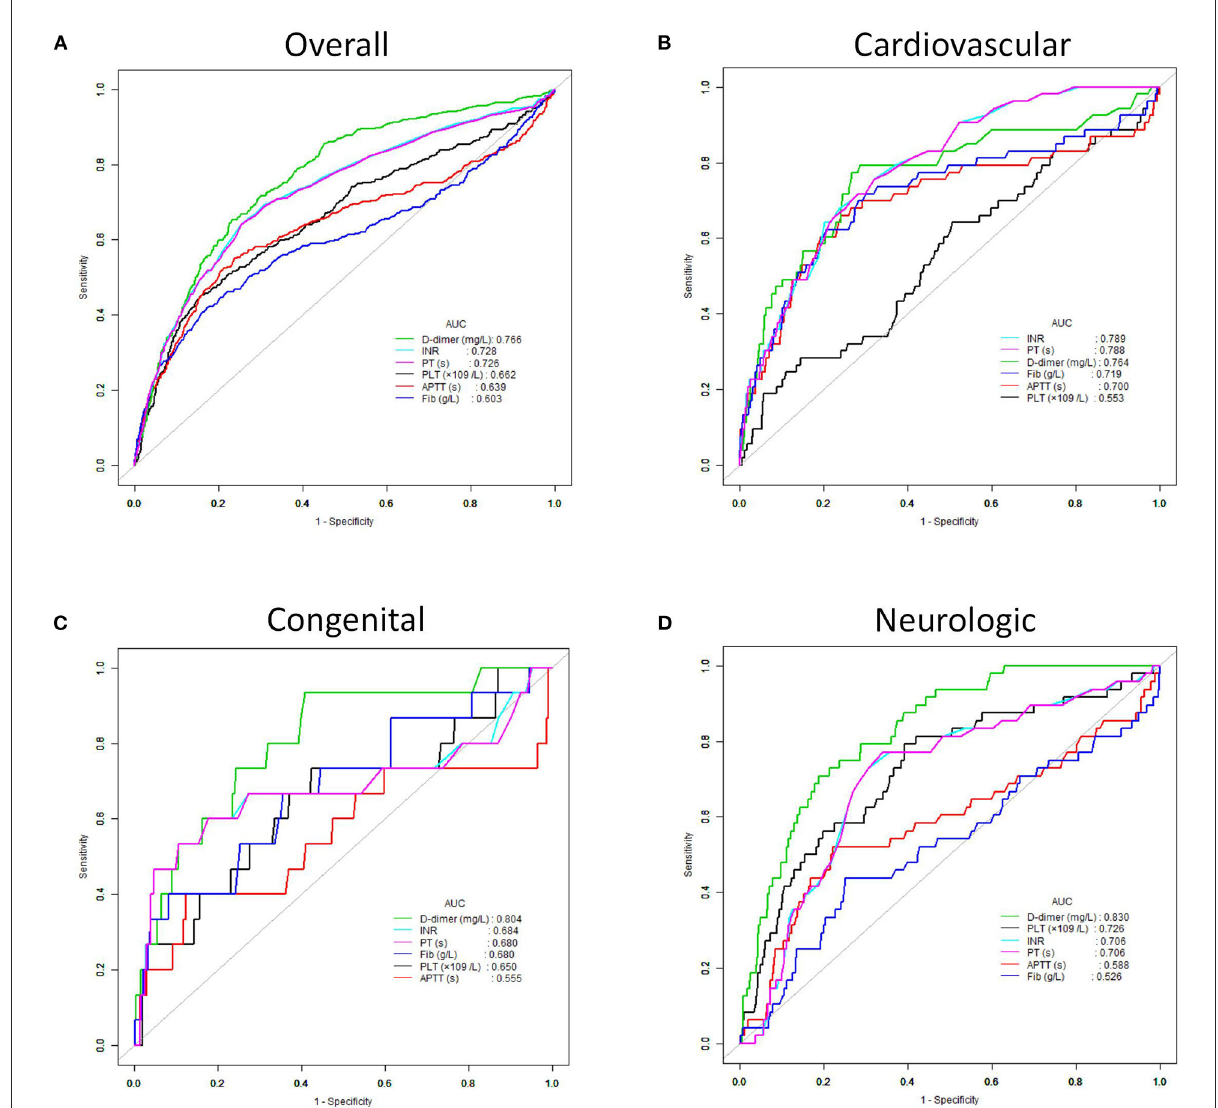
FIGURE2 Receiver operating characteristic (ROC) curves of the D-dimer, INR, PT, APTT, Fib and PLT for predicting in-hospital mortality. (A) All critically ill patients. (B) Patients with cardiovascular disease. (C) Patients with congenital disease. (D) Patients with neurologic disease.